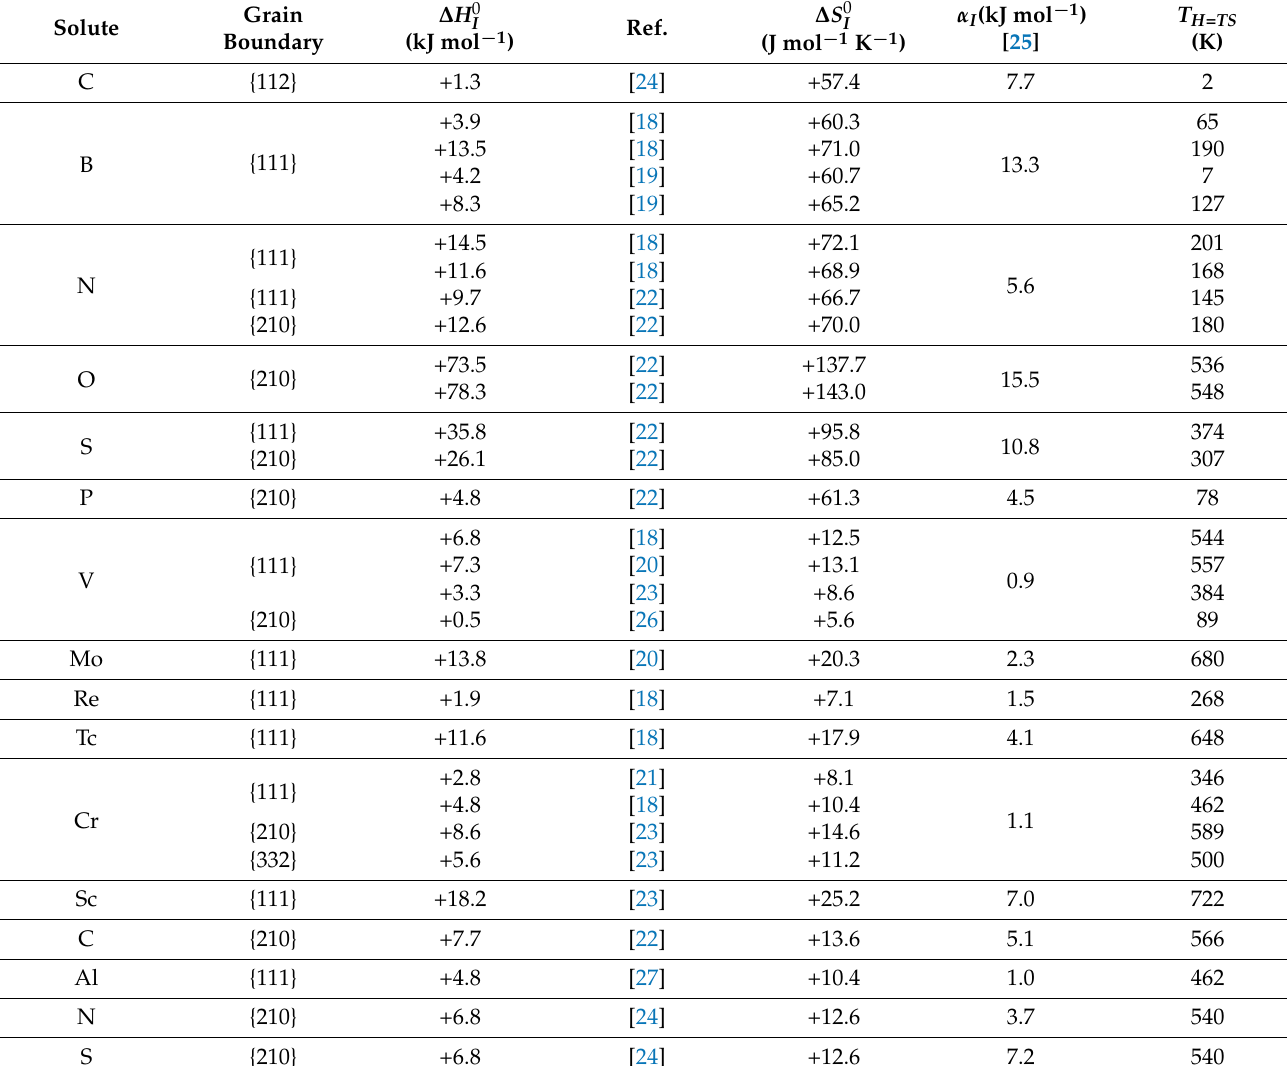
Table 1. Some candidates of the grain boundary sites and solutes to exhibit entropy-driven grain boundary segregation in α -iron. The values of the segregation enthalpy (energy), ∆ H 0 , were calculated by DFT methods in the respective references. I Values of the entropy, ∆ S I , were determined according to Equation (7) from [25]. α I is the binary (Fowler) interaction coefficient estimated according to data from [25]. T H = TS is the temperature for the equal contribution of enthalpy